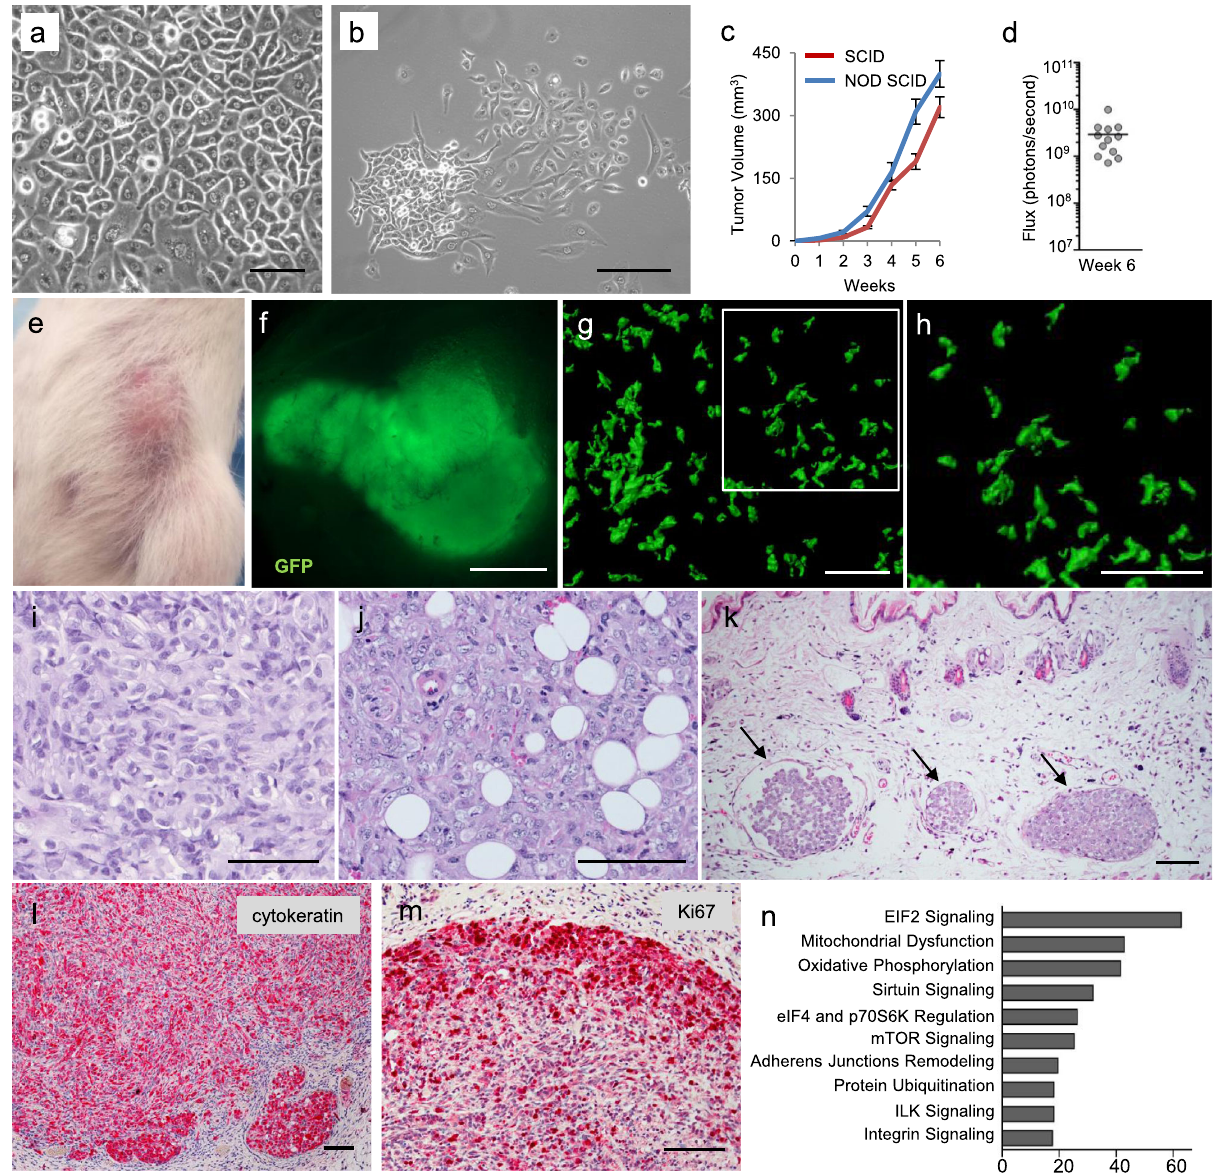
Fig. 1 Characteristics of A3250 tumor cells in vitro and tumors in vivo. a Bright- fi eld microscopy of con fl uent A3250 tumor cells in vitro. b Morphology of A3250 tumor cell clones in vitro. Images are representative of three independent experiments. c Tumor growth following orthotopic injection of 10 6 A3250 tumor cells in SCID or NOD SCID mice measured by caliper weekly. NOD SCID n = 8 and SCID n = 6 biologically independent mice. Data represent mean ± SEM (Standard Error of the Mean). d Bioluminescence imaging of A3250 tumors in SCID mice at week six ( n = 12 mice). Black line denotes mean value. e Representative picture of an A3250 tumor at 6 weeks showing erythema of the skin and fl at tumor appearance. f Fluorescence stereo-microscopy of an A3250 tumor (GFP, green) ex vivo. g A3250/GFP 300 μ m tumor section imaged by confocal microscopy and reconstructed in 3D. Note diffuse pattern of growth. (GFP, green) ( h ). Higher magni fi cation of boxed area in ( g ). H&E staining of paraf fi n embedded tumor sections ( i , j ) and overlying skin ( k ). Note the presence of lymphovascular emboli in the dermis ( k , arrows). IHC staining for cytokeratin ( l ) and for the proliferation marker Ki-67 ( m ). Images are representative of three independent experiments. n = 4 biologically independent mice. n Top ten A3250 canonical pathways based on mRNA- Seq of A3250 tumors, determined by IPA. Top pathways are ranked based on p values. Scale bars: a , b , 100 μ m; f , 2 mm; g – m , 100 μ m. Source data are provided as a Source Data fi